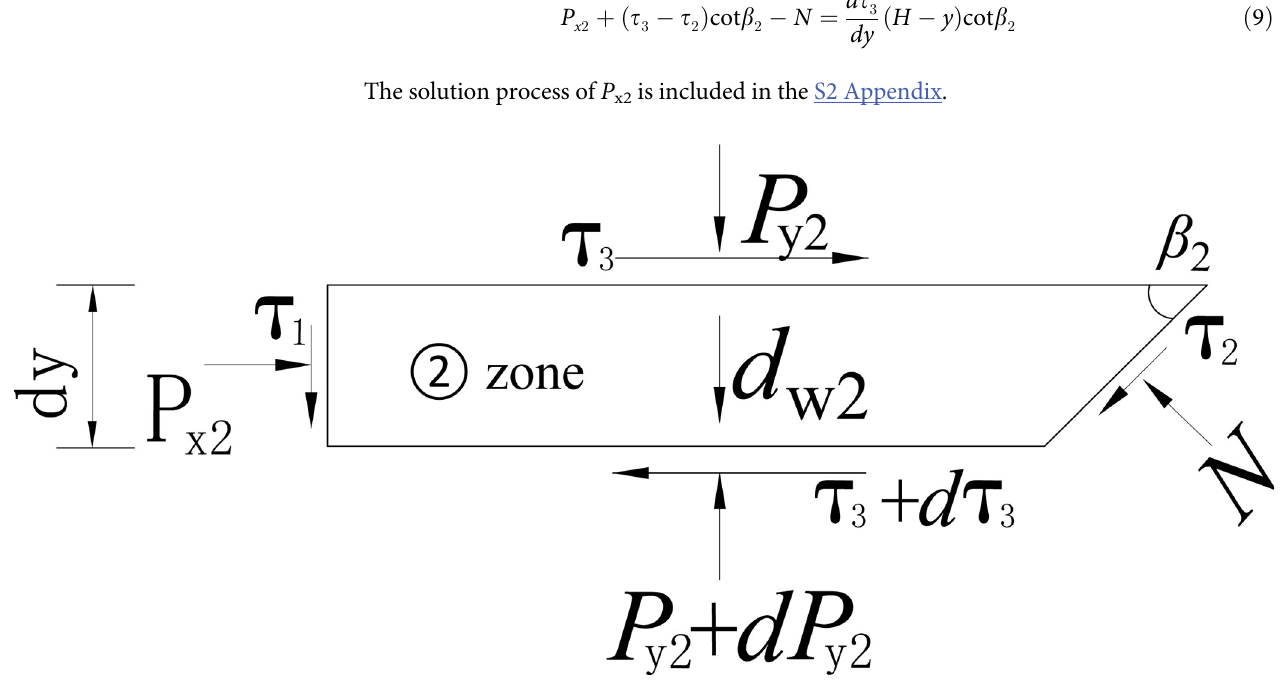
Fig 17. Forces analysis on zone ②